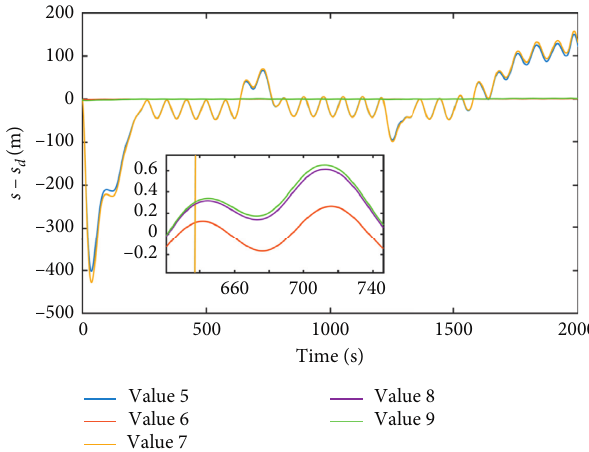
Figure 10: Position tracking error of the HST.